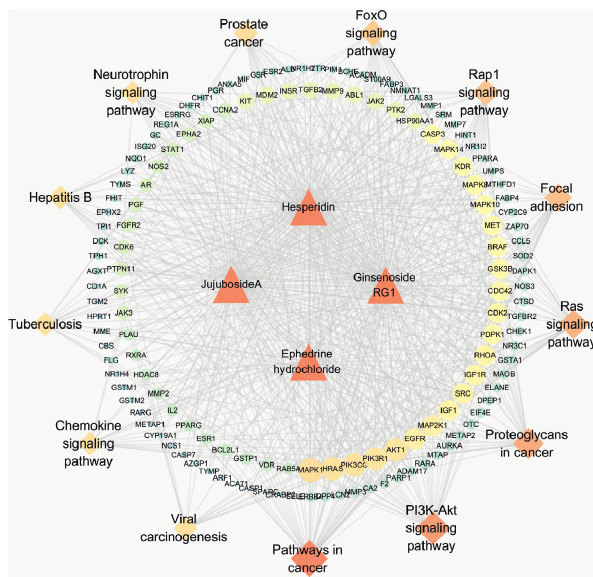
Figure 14: Main components-target-pathway network of LJZD.